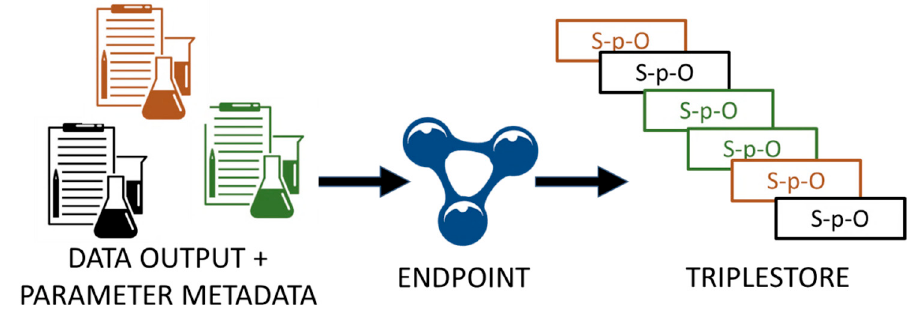
Figure 7. The goal of creating an endpoint is to automatize the populating process of the triplestore from the metadata files from experimental tests.